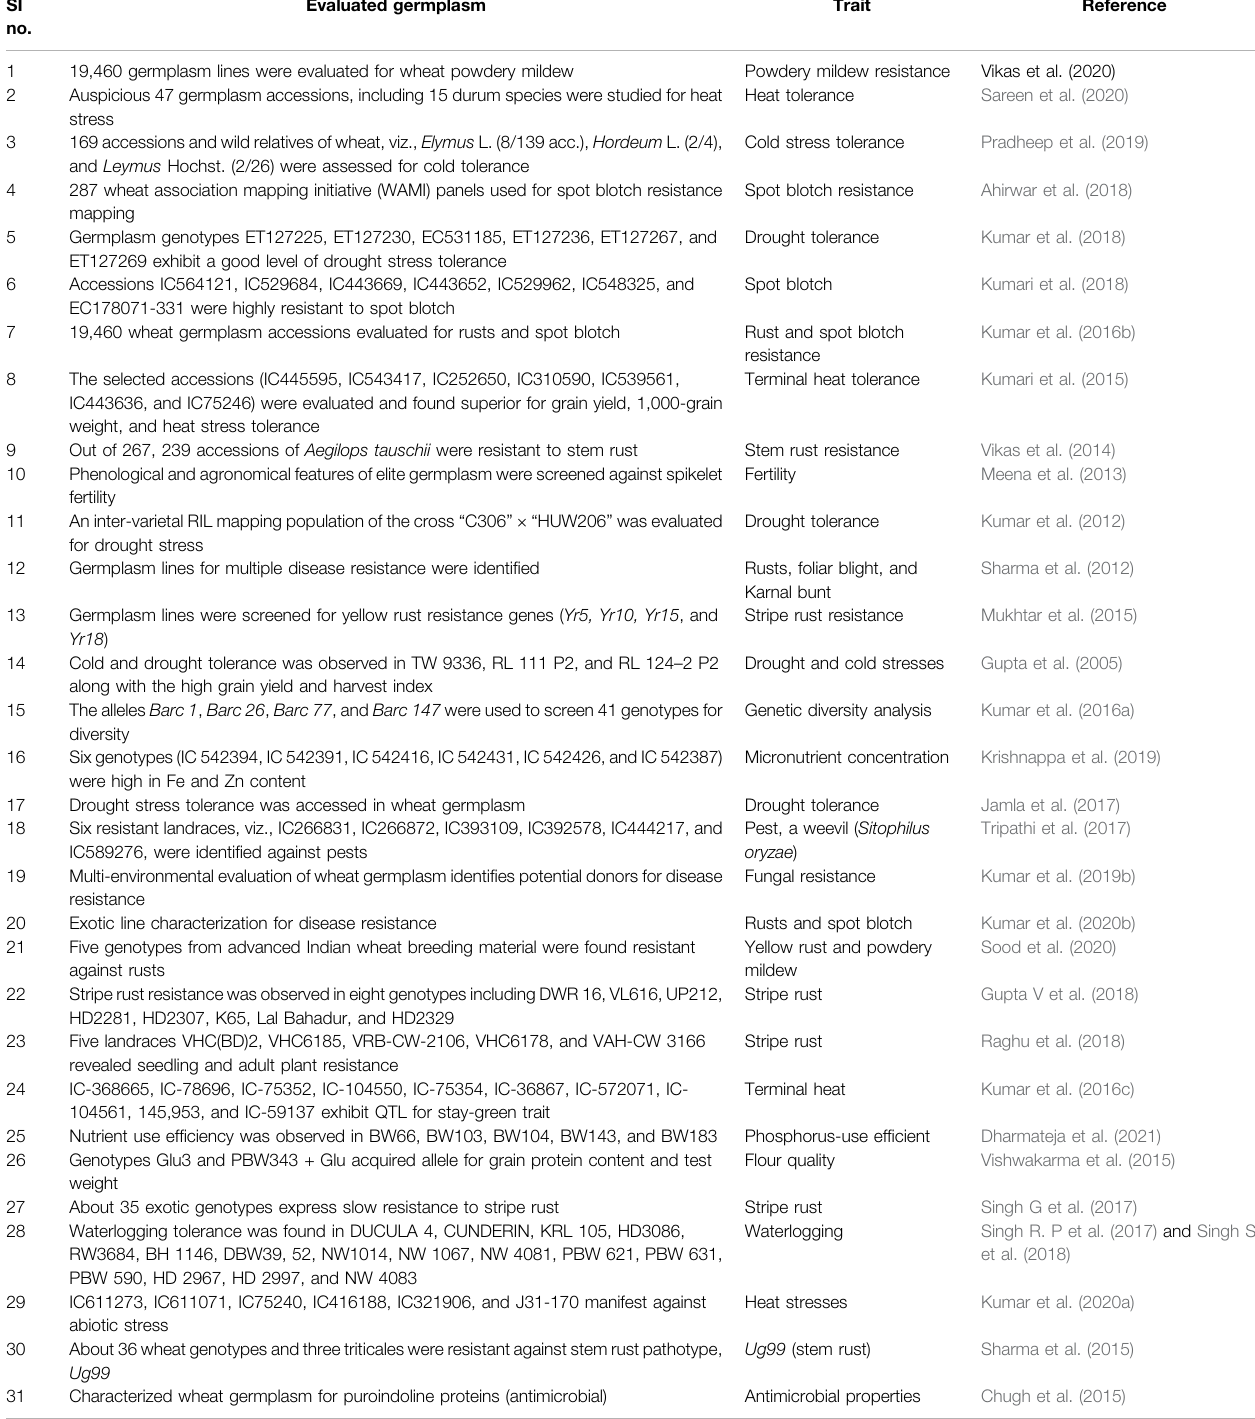
TABLE 2 | Recently harnessed wheat germplasm for biotic and abiotic stresses and nutrient-use ef fi ciency to improve crop productivity. SI